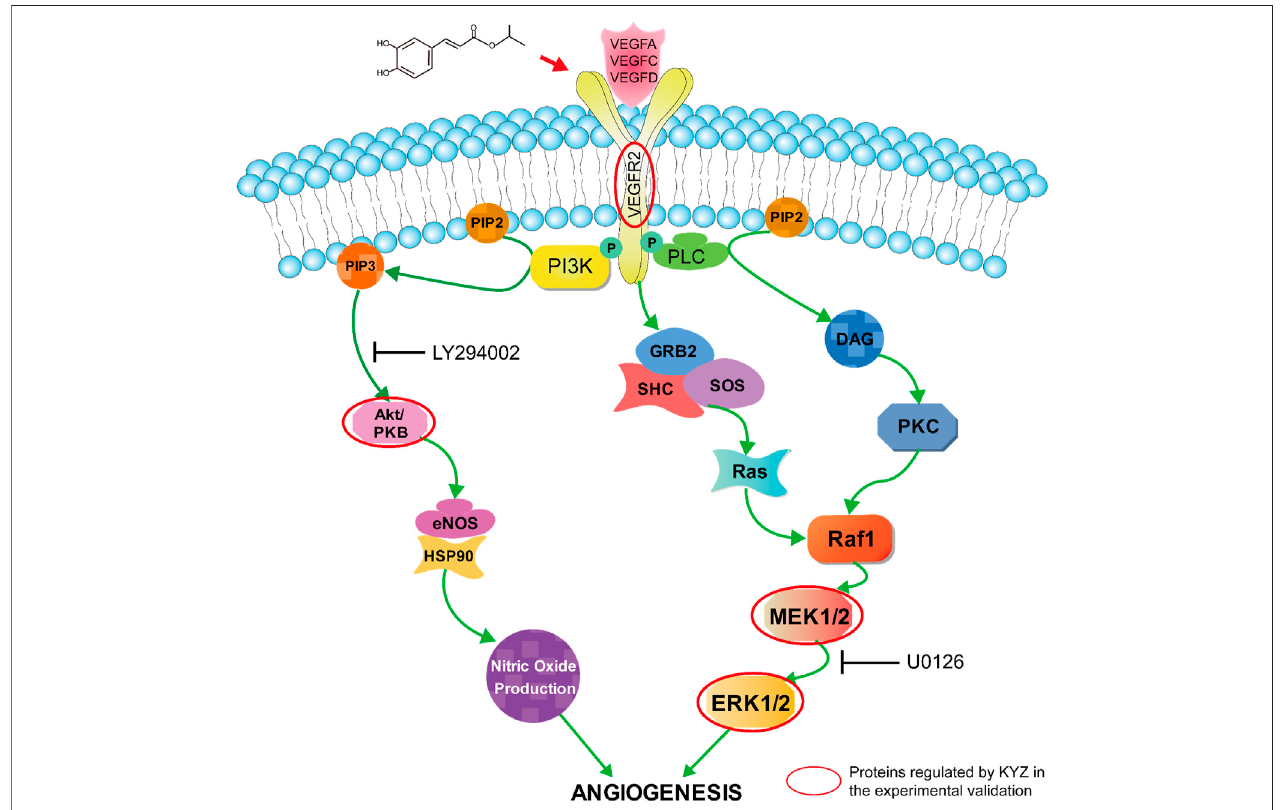
FIGURE 11 | The possible mechanism responsible for promoting angiogenesis of KYZ, the proteins circled in red are the direct targets of KYZ.